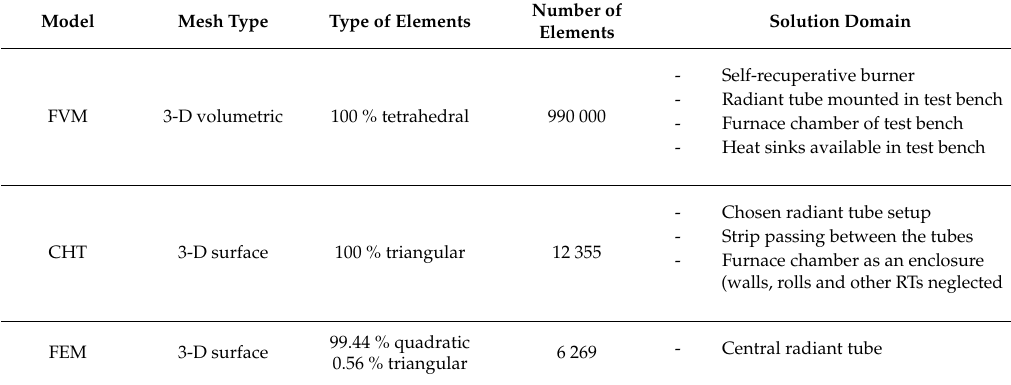
Table 1. Outline of chosen discretizations for the finite volume method (FVM), coupled heat transfer (CHT), and finite element method (FEM) models.